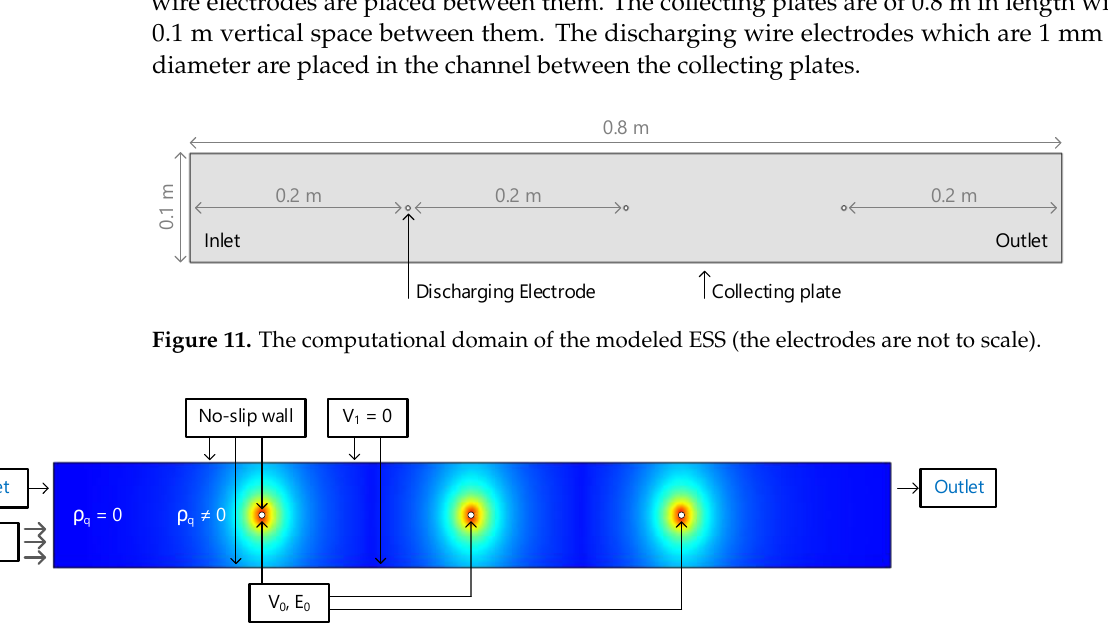
Figure 12. The computational domain boundary conditions.